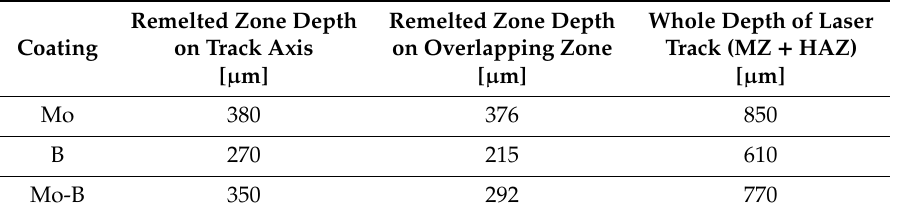
Table 3. Average dimensions of laser